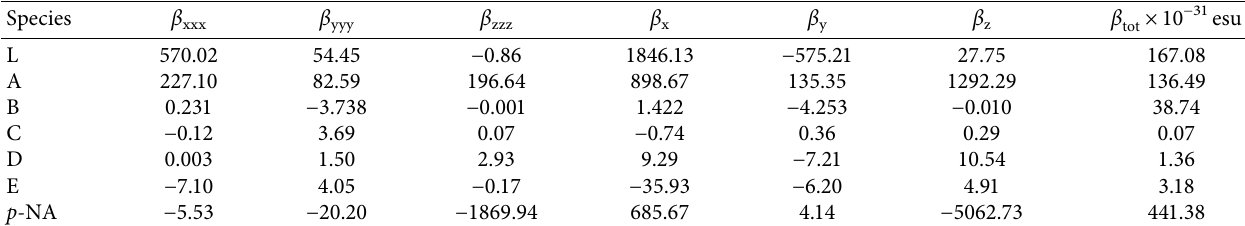
Table 10: Total static average first hyperpolarizabilities ( β tot ) alongside some of its components for L, transition metal complexes, and p-NA, calculated at ω � 0 at the wB97xd/6-311++G level of theory.